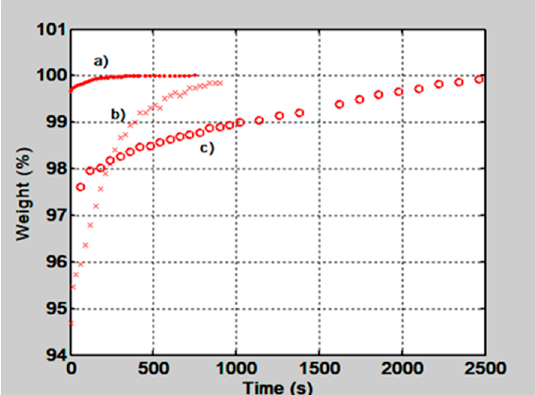
Figure 2. Normalized films weight as a function of time when they were placed in a microbalance and let them absorb environmental water molecules. Plot a) is for a gelatin film with a thickness of 15 µm, plot b) for a 50 µm film and plot c) for a poly(vinyl alcohol) (PVA)/poly(acrylic acid) (PAA), 50 µm film.